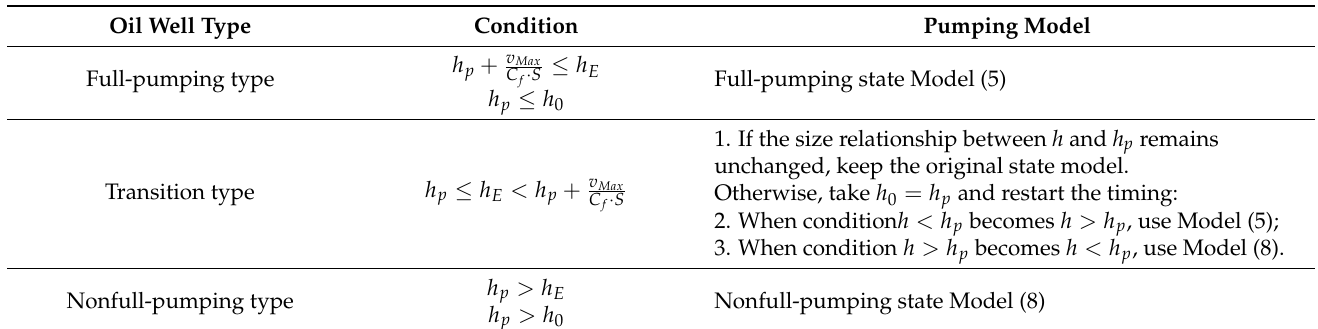
Table 1. Relationship between discriminant conditions and pumping